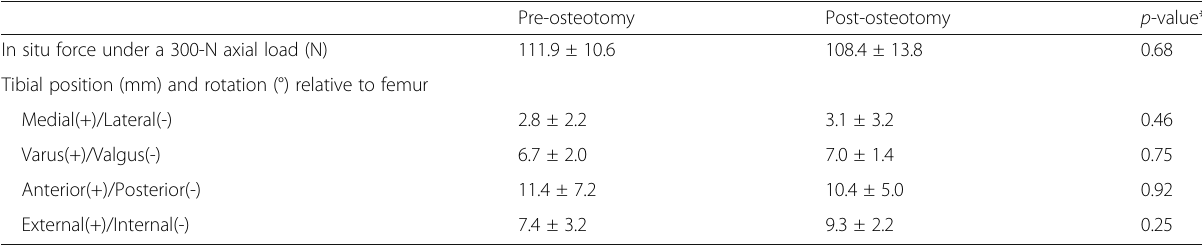
Table 1 Differences between pre and post osteotomy in in situ force of medial meniscus and tibiofemoral relationship at 60°of knee flexion ( n = 5)